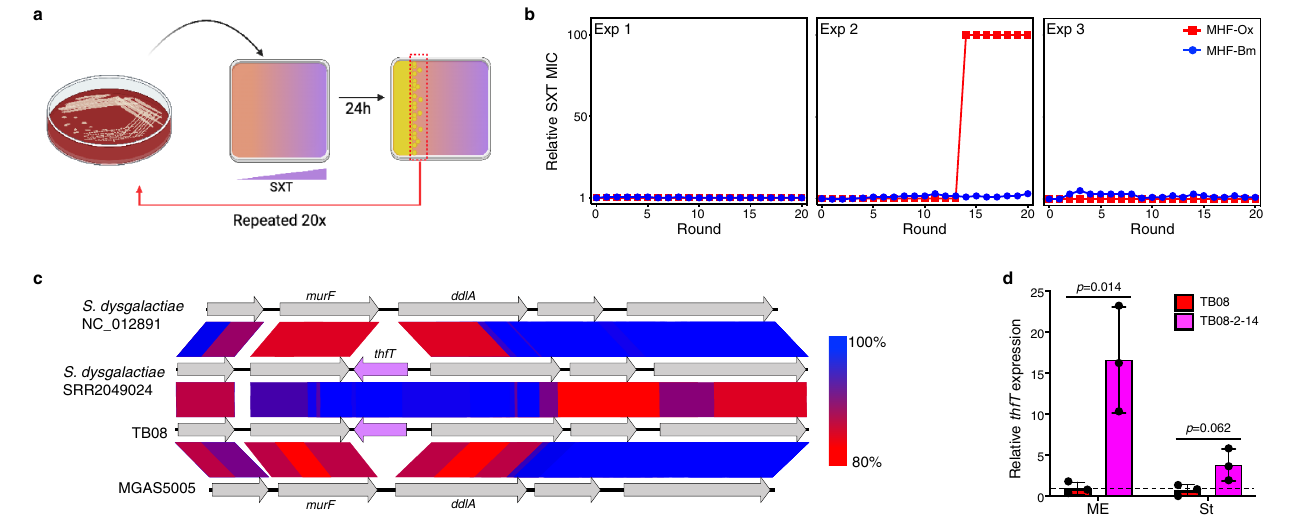
Fig. 2 | A DfrG-positive GAS strain can evolve SXT resistance due to upregula- tion of an ECF transporter S component gene ( thfT ). a Schematic of in vitro evolution procedure using SXT gradient plates. An overnight culture of TB08 on HBA was used to inoculate a SXT gradient plate (0 – 50 μ g/ml) and incubated for 24h at 37°C. Growth was then harvested from the the highest antibiotic con- centration (i.e. where growth started to be inhibited) and used to seed successive roundsofevolution.CreatedwithBioRender.com. b MICstoSXTonMHFagarfrom bioMerieux (MHF-Bm; blue circles) and Oxoid (MHF-Ox; red squares) following invitroevolutionofGASstrainTB08.Resultsfromthreeindependentexperiments are shown. Values areexpressed asa ratioof the initialMIC asdetermined by Etest